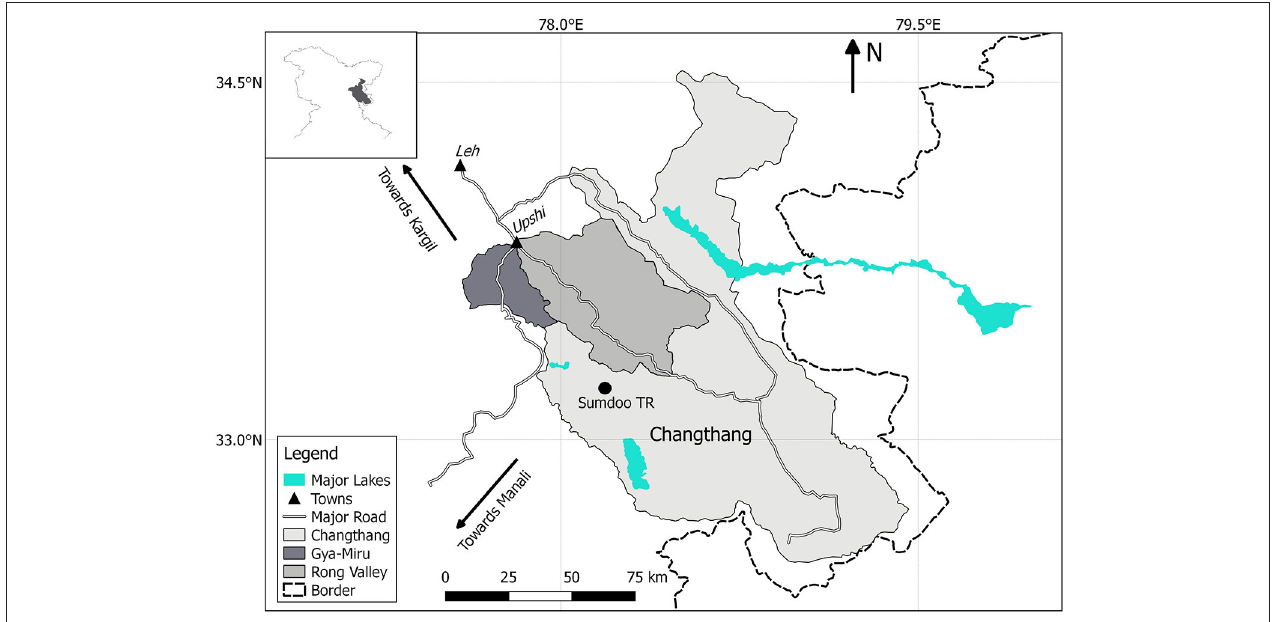
FIGURE 1 | Map displaying the Eastern Ladakh region (primarily consisting of Gya-Miru, Rong valley, and Changthang) and the location of Sumdoo TR.